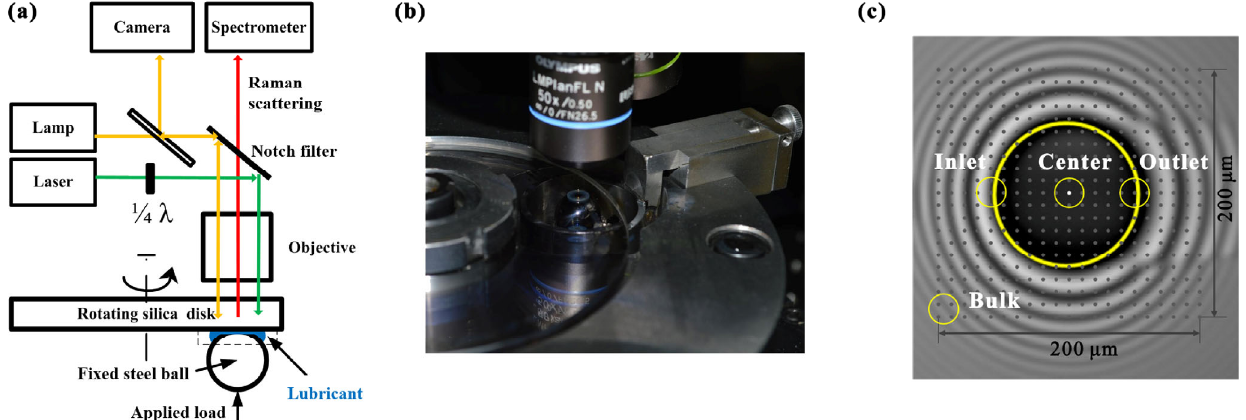
Fig. 1 (a) Schematic and (b) image of the experimental apparatus; (c) the schematic of the measuring